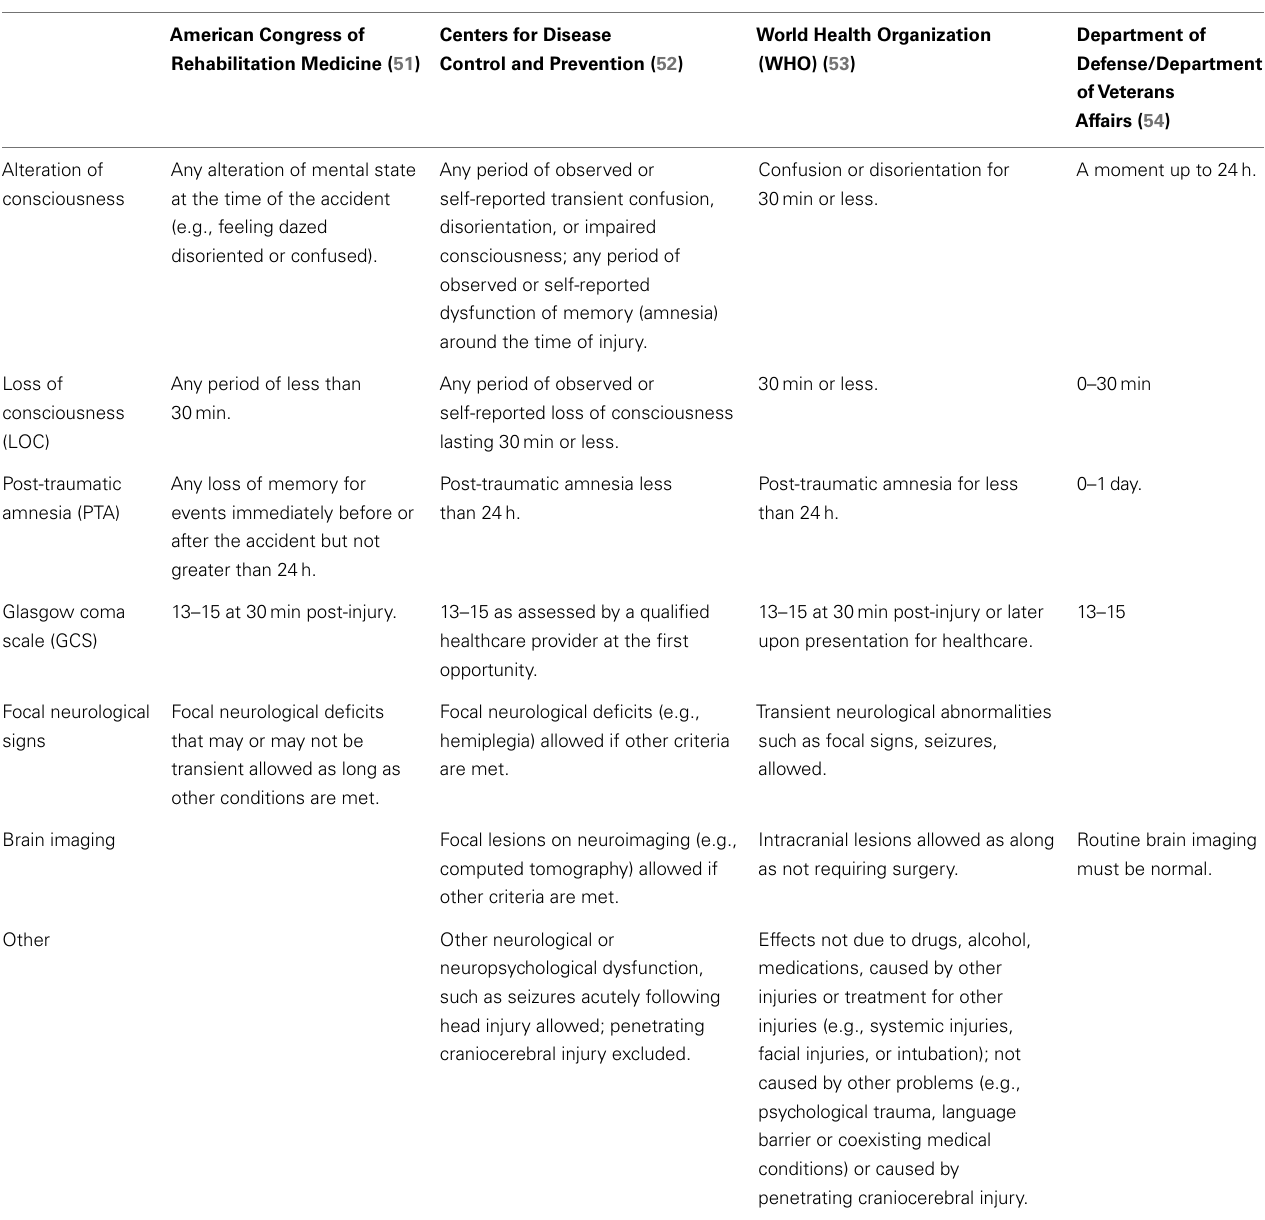
Table 1 | Consensus criteria for the classification of human mTBI